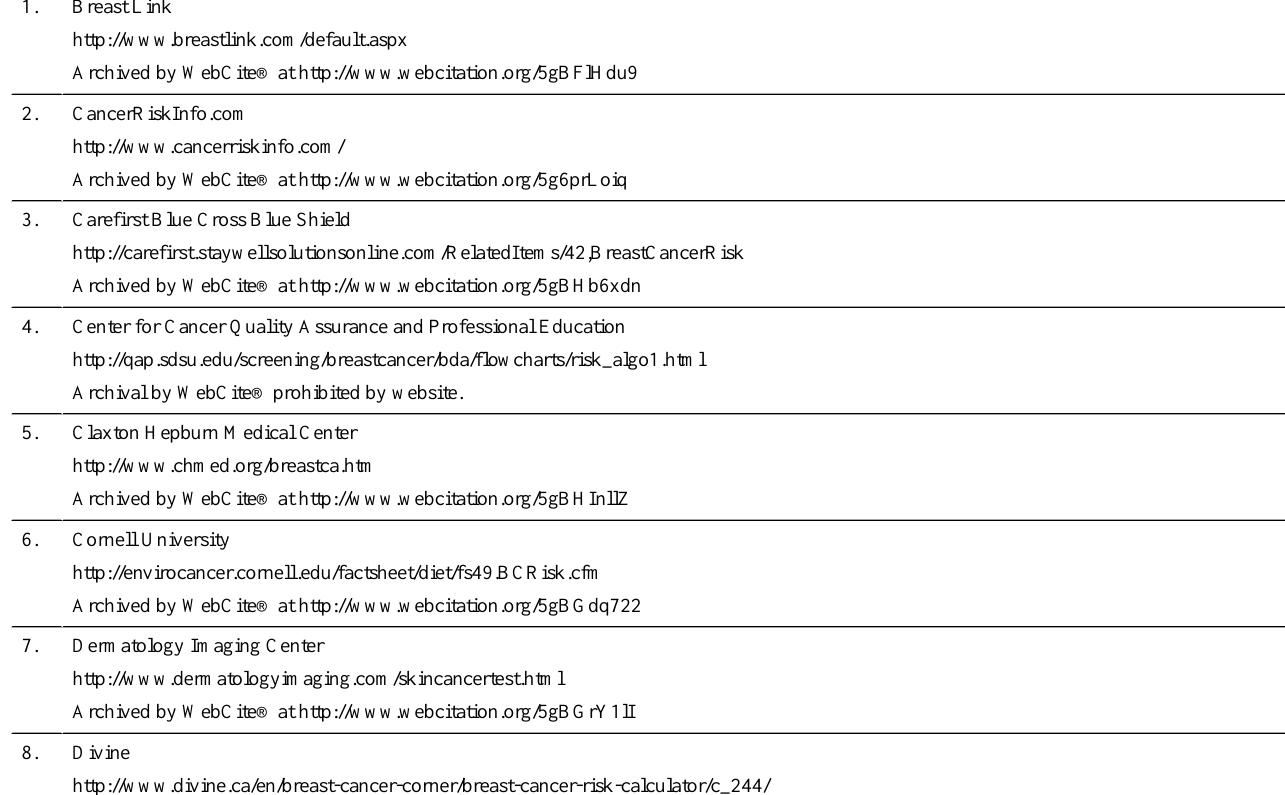
Table 2. Websites hosting cancer risk assessment tools (WebCite ® links are listed below the original URL) Breast